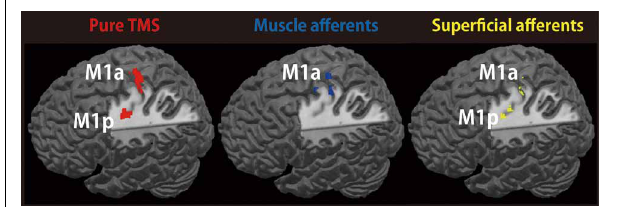
FIGURE 3 | Representations of TMS-, muscle afferent- and superficial afferent-induced brain activity within M1 subdivisions. Muscle afferent-related brain activity was predominantly distributed in M1a while superficial afferent-related activity was seen in both M1a and M1p. Pure